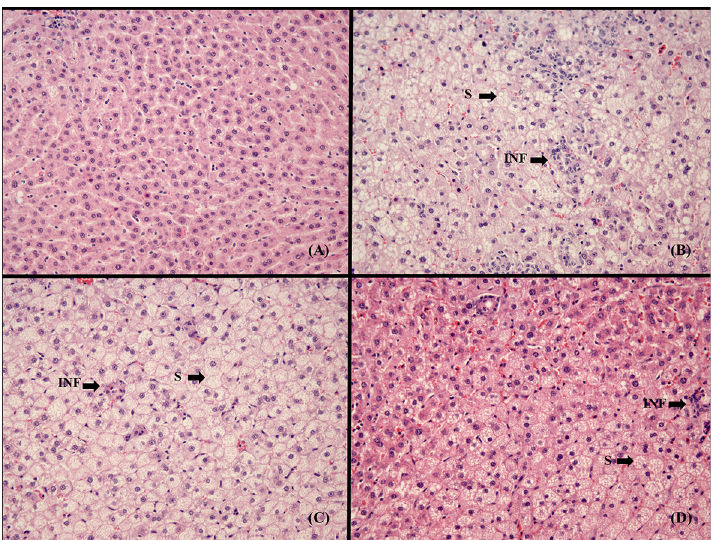
Fig 1. Histological evaluation of liver. Images represent liver sections at 20x magnification of the experimental groups. (A) C, control diet; (B) CHOL-C, cholesterol enriched high saturated/high cholesterol control diet; (C) CHOL-HxT, hydroxytyrosol RP cholesterol enriched high saturated/high cholesterol diet; (D) CHOL-Si, silicon RP cholesterol enriched high saturated/high cholesterol diet; S, hepatic steatosis; INF, inflammatory cell infiltration